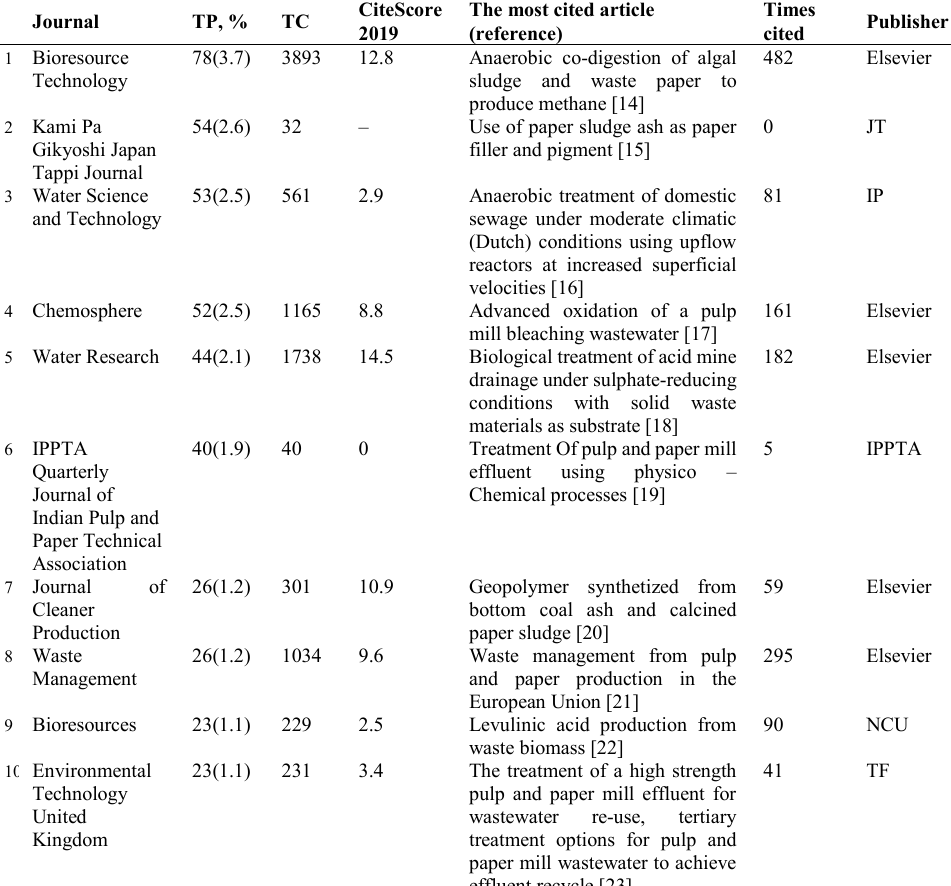
Table 1 presented 6 type of publisher dominate the top 10 most popular publications, where first ranked governed by Elsevier with five in total. Others included Japan TAPPI (JT),